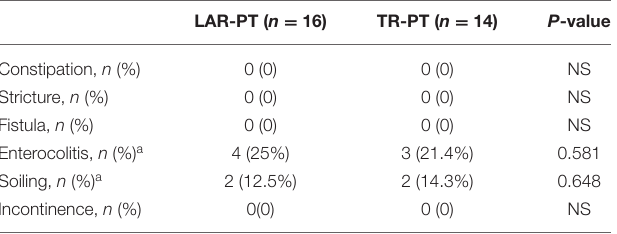
TABLE 3 | Late post-operative complications and long-term